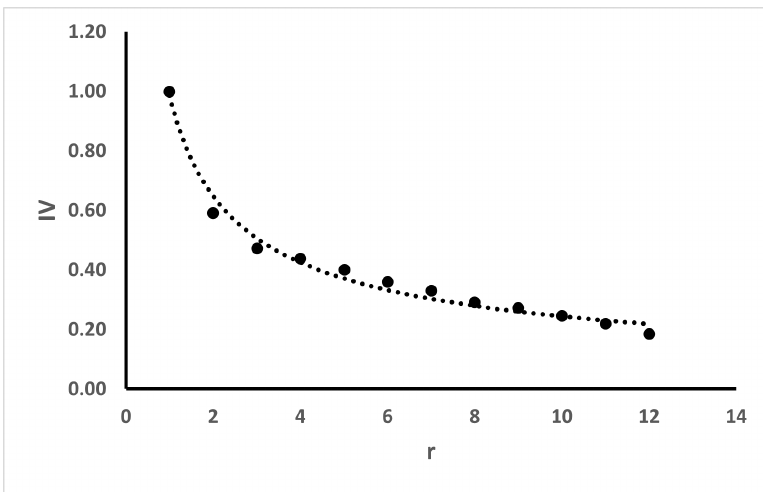
Figure 8. IV = f ( r )—Normalized Mean Curve.